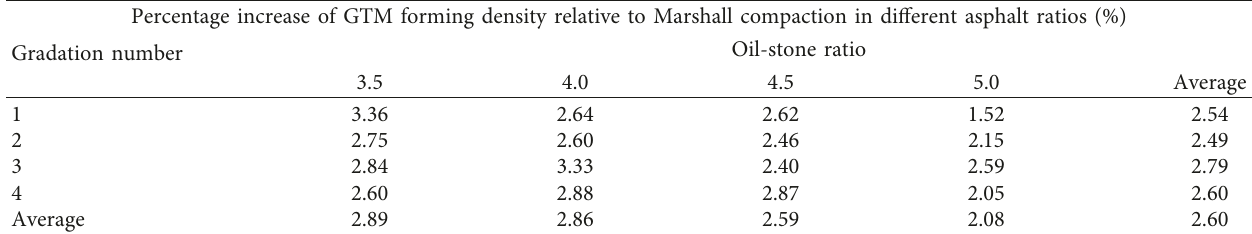
Table 7: Difference in bulk density for the two methods of asphalt mixture design.